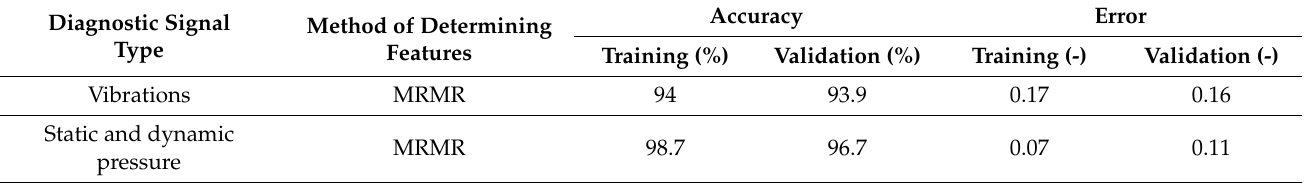
Table 6. Accuracy and error values during training and network